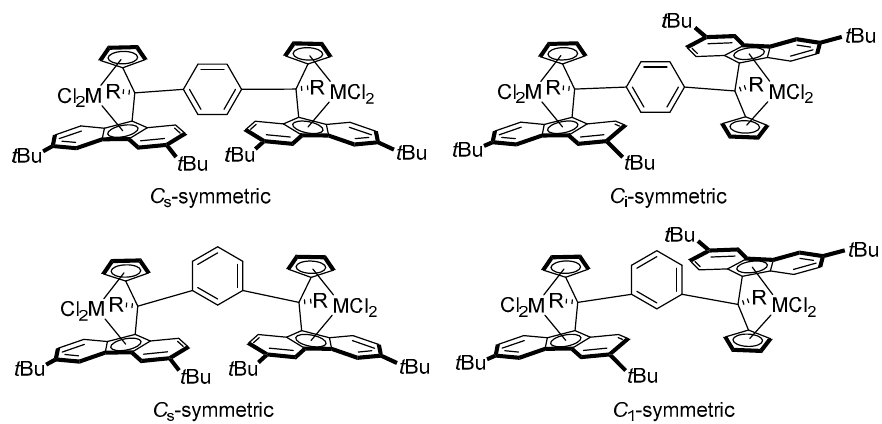
Scheme 5. Possible diastereoisomers of the phenylene-bridged bis(dichloro ansa -metallocene)